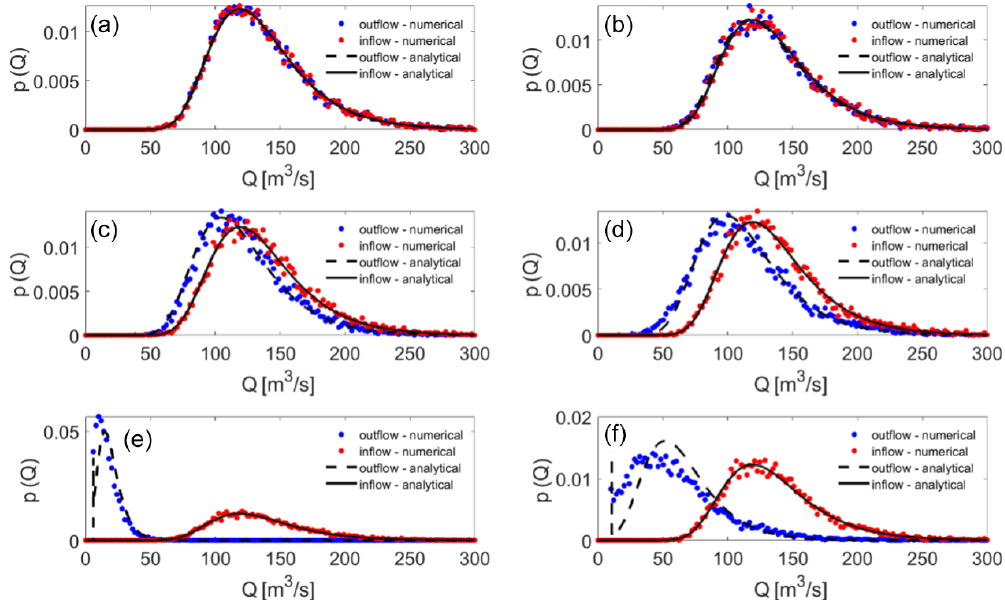
Figure 5. Comparison between derived probability density functions of the outflow (continuous black line for the inflow and dashed black line for the outflow) and the empirical PDFs obtained via numerical hydraulic simulation (red dots for inflow and blue dots for outflow). Graphs provide the following parameterizations: (a) w 1 = 2000; h s = 4m; (b) w 1 = 1500; h s = 9m; (c) w 1 = 5000; h s = 4m; (d) w 1 = 3000; h s = 10m; (e) w 1 = 40000; h s = 4m; (f) w 1 = 6000; = 10m. Remaining parameters are α = 30m 3 /s; β = 120m 3 /s; b = 1m; d = 1m;